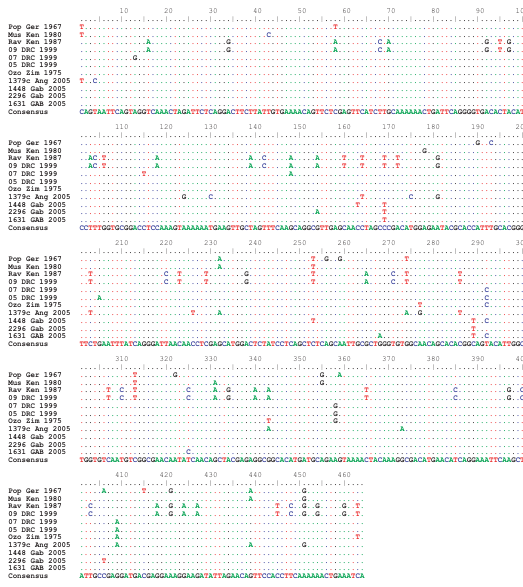
Figure 2. Phylogenetic analyses and nucleotide sequence alignments of NP and VP35 sequences derived from bat tissues. A) Maximum likelihood analysis of the concatenated NP (464 nt) and VP35 (302 nt) sequence fragments obtained from each bat specimen and 18 MBG virus isolates. Bootstrap support values are indicated at the nodes. Abbreviations of historical isolates are Rav=Ravn, Ozo=Ozolin, Pop=Popp and Mus=Musoke. B-C) Nucleotide alignment of the sequences in (A) in which the lineages from the Angola 2005 outbreak are singly represented by Ang1379c. 1:1600 dilutions. Bat IgG was detected using Protein A-G peroxidase or HRP-conjugated goat sera raised against a cocktail of IgG from six diverse bat species. Bats of the species Epomops franqueti (N =47) were used as the negative control group.